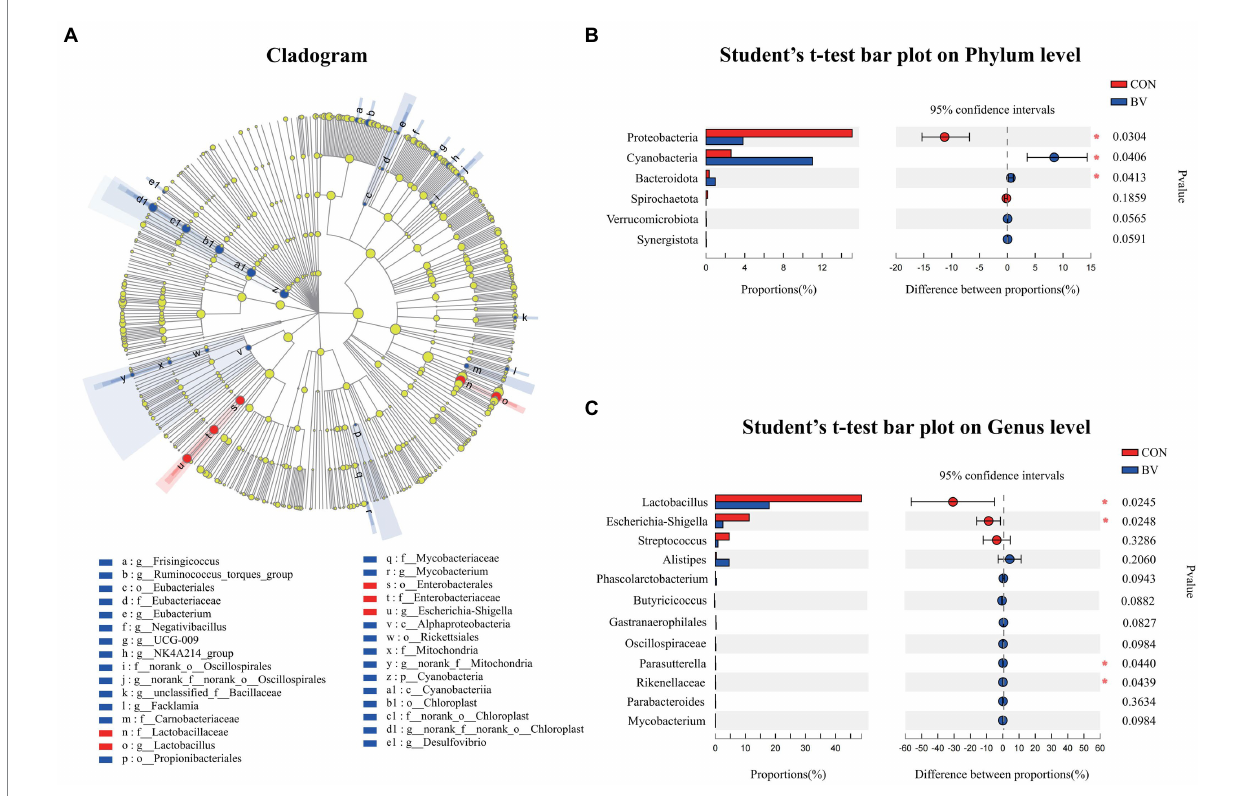
FIGURE 7 Effect of Bacillus velezensis LB-Y-1 on the abundance of the ileal microbial community of broilers ( n = 6). (A) Cladogram of LEfSe multilevel species difference discriminant analysis (LDA > 2), different color nodes indicate microbial communities that are significantly enriched in the corresponding groups and significantly different between groups. (B,C) Comparative analysis of the relative abundance of bacteria at the phylum and genus levels, respectively. Values are presented as Mean ± SEM, the values having superscript (*) were significantly different, *0.01 < p < 0.05; ** p ≤